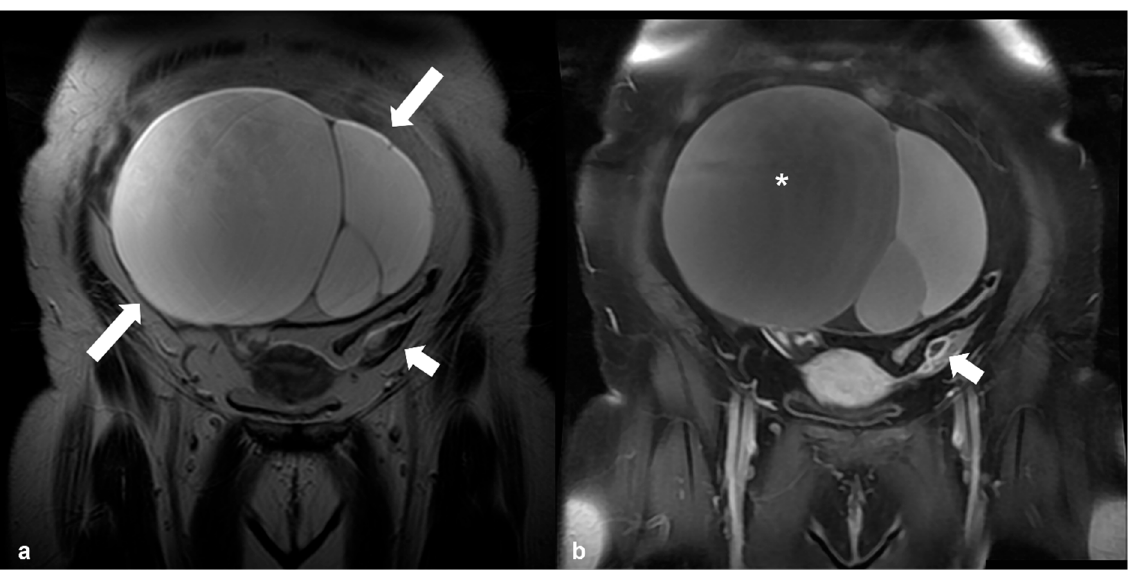
Figure 6. Mucinous cystadenoma . T2 weighted image ( a ) in the coronal plane, shows a large multilocular cystic mass originating from the right ovary (arrows). Corresponding T1 CE FS image ( b ) shows different signal intensity of various compartments (asterisk), the so-called ‘stained-glass’ appearance. Shown also is the normal left ovary (short arrow in ( a,b )).